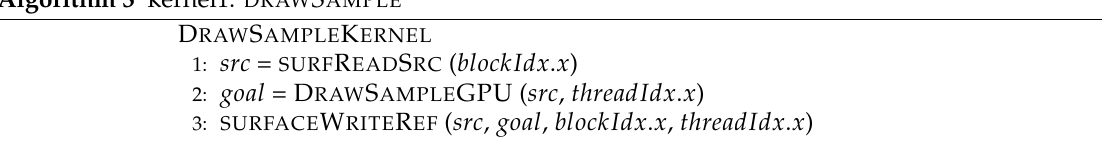
Algorithm 3 kernel1: DRAW S